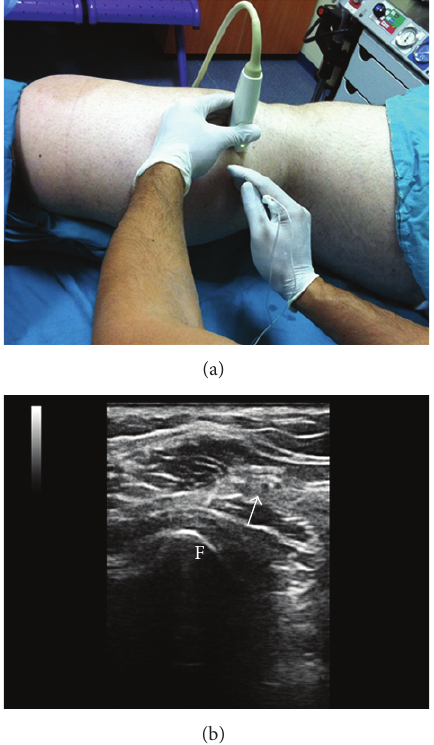
Figure 2: (a) Ultrasound probe placement for common peroneal nerve block at the head of the fibula. (b) Sonogram of the common peroneal nerve at the head of the fibula (arrow). F: